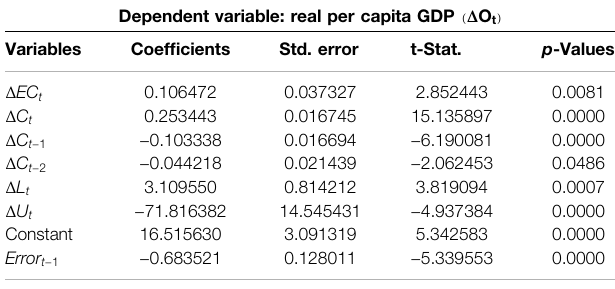
TABLE 3 | Estimated long-run coef fi cients based on the ARDL model selection. TABLE 4 | ARDL short-run parameter